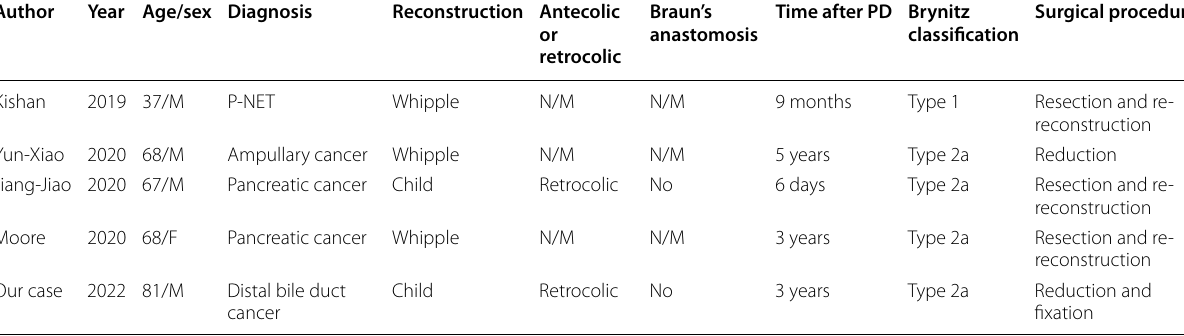
P-NET , pancreatic neuroendocrine tumor, PD pancreaticoduodenectomy, N/M not